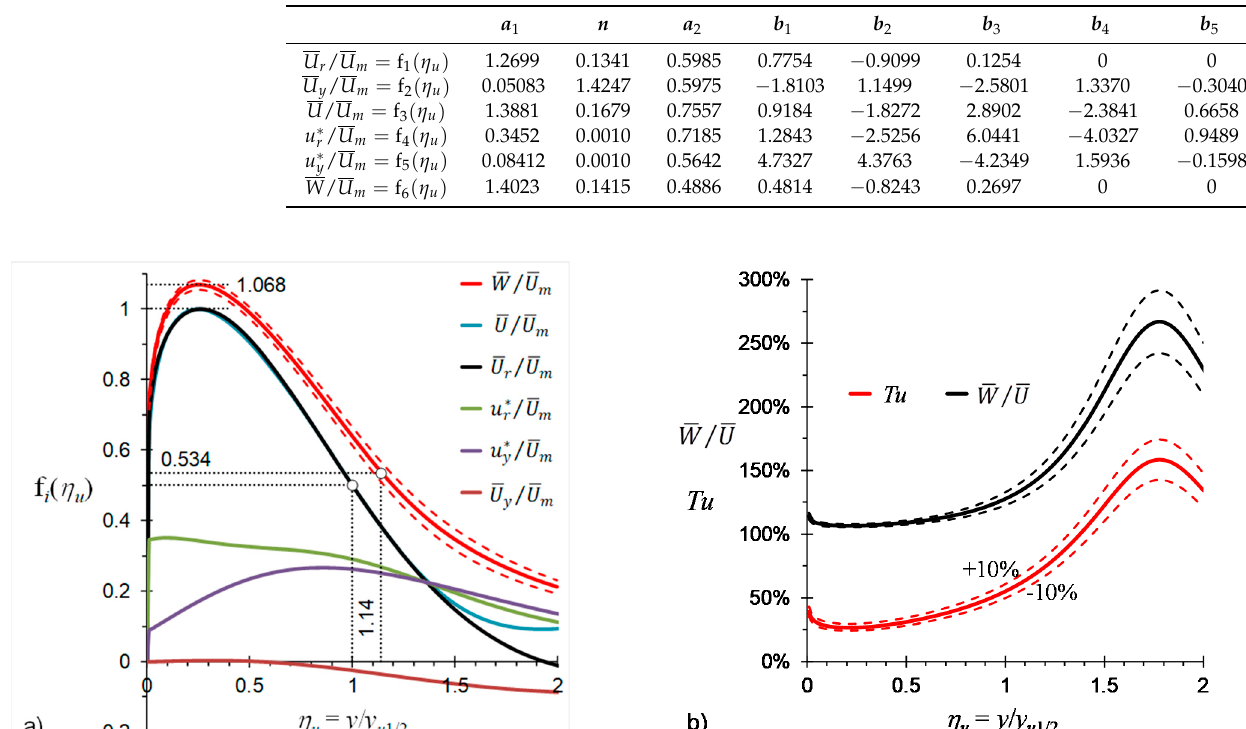
Figure 3. Profiles of velocity and turbulence in the RWJ self-similarity zone determined based on the results of measurements presented in [16] and using the method of converting the mean velocity into the mean speed presented in [34]: ( a ) mean velocity U , mean velocity components U r and U y , standard deviations of velocity fluctuations u ∗ r and u ∗ y , and estimated mean speed W ; ( b ) turbulence intensity Tu and the ratio of mean speed and mean velocity W / U